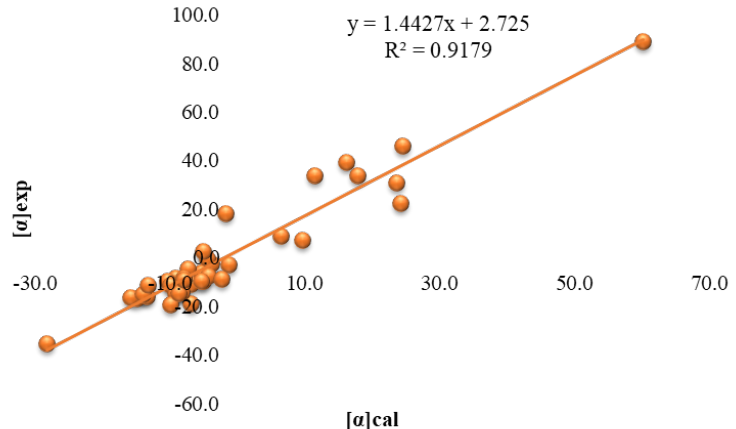
Figure 4. Linear dependence between [α]cal and [α]exp.